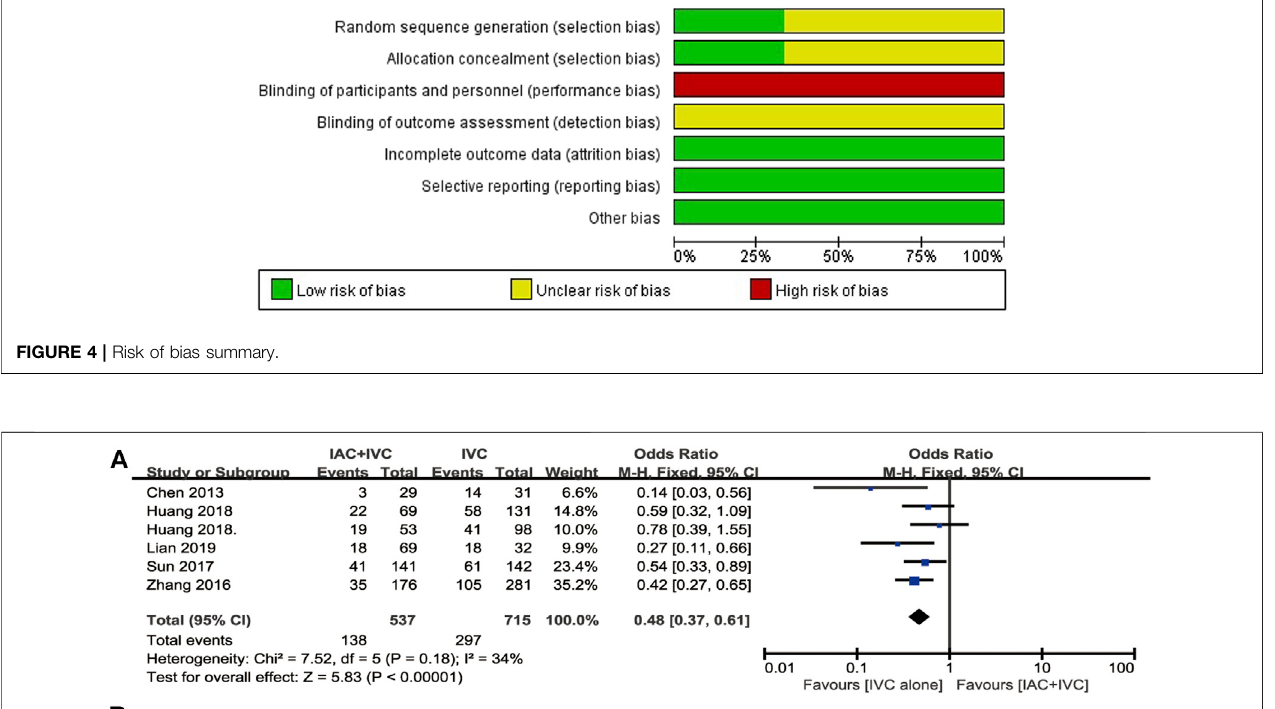
Frontiers in Pharmacology |